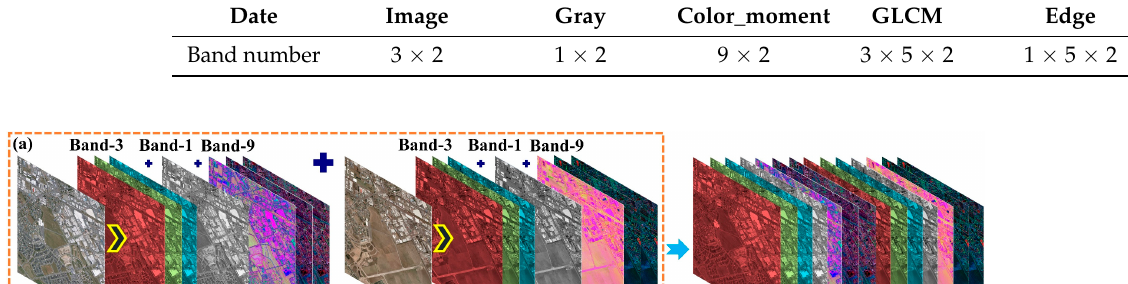
Table 1. The number of bands for each feature.